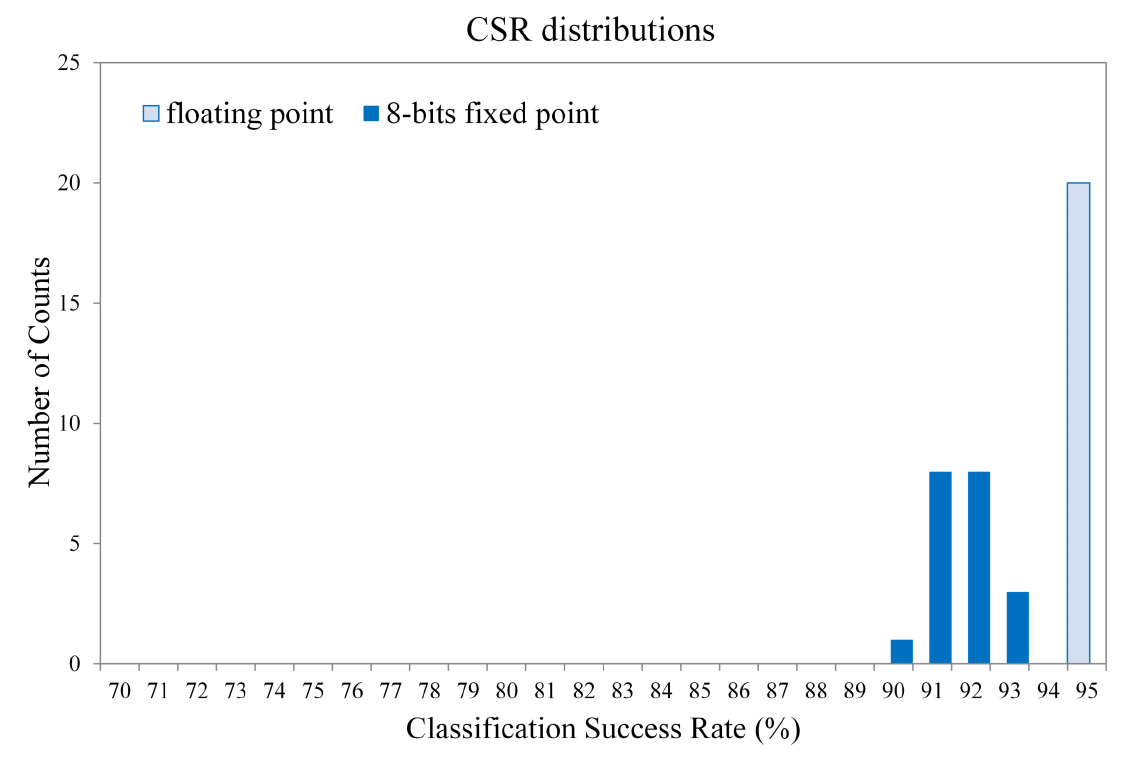
Figure 22. The CSR distribution of GHA with fixed and floating point